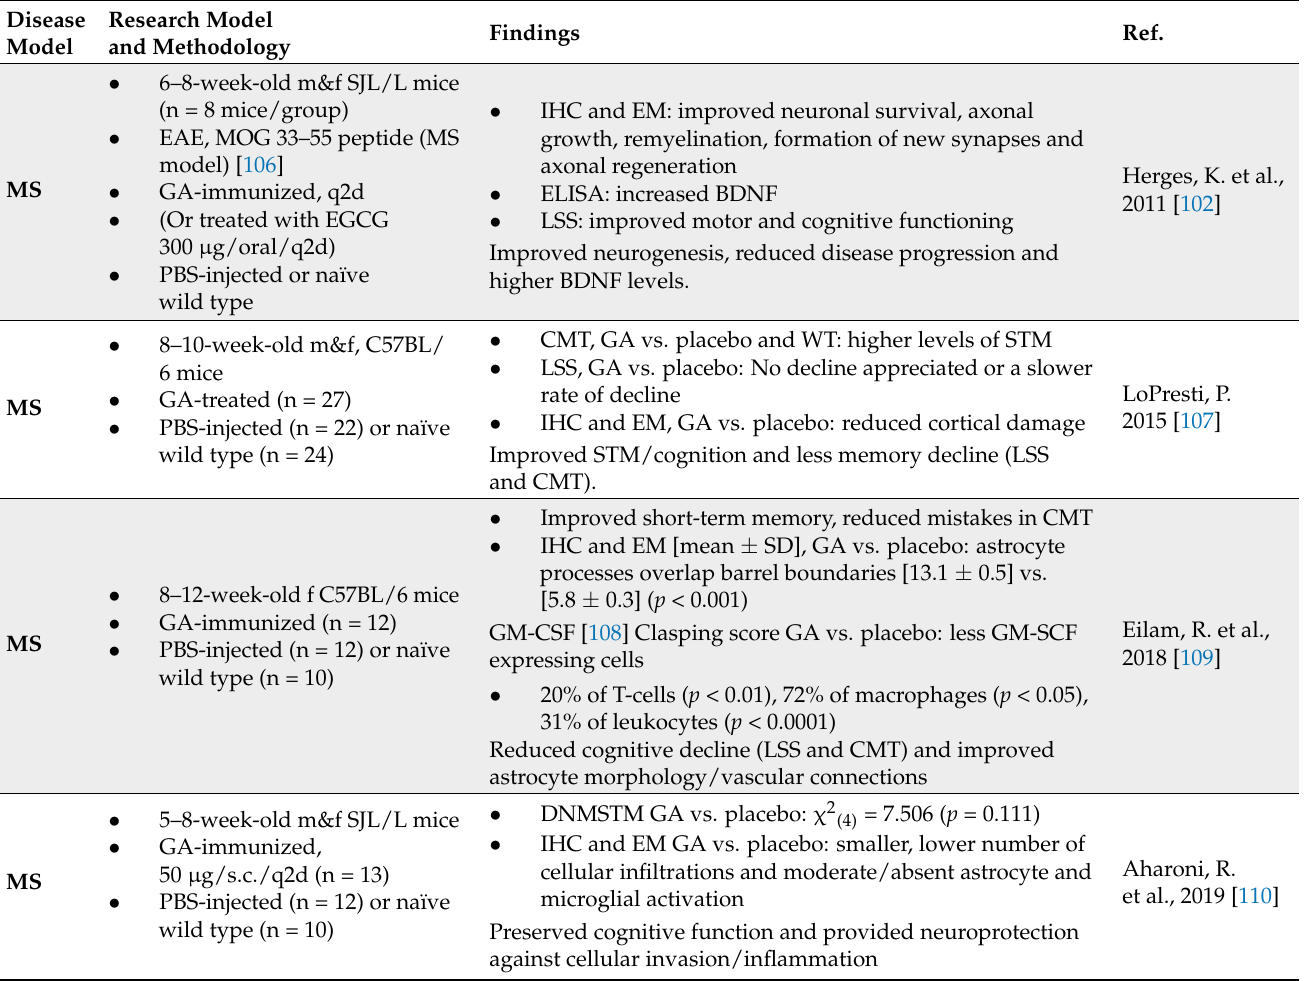
Table 4. Animal Studies Examining Alternative Glatiramer Acetate Outcomes in Multiple